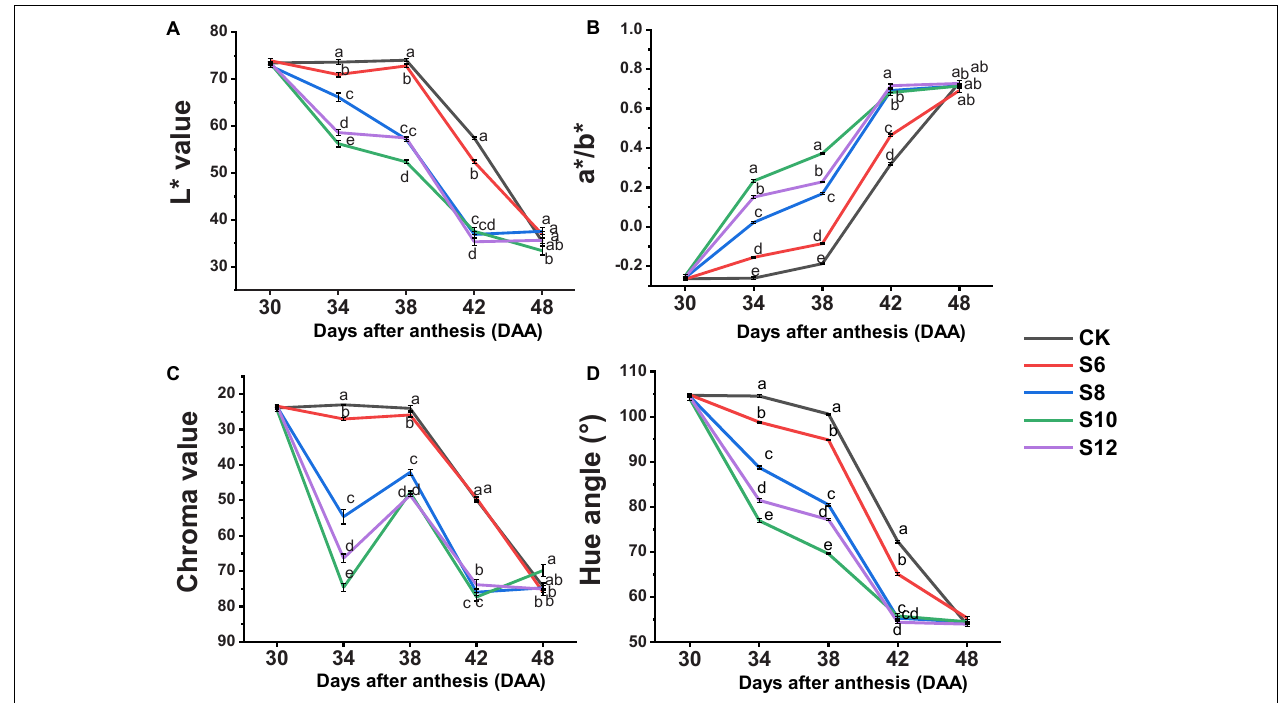
FIGURE 3 | Effect of different supplemental blue light frequencies on surface color values [L*, a*/b*, chroma, and hue angle; (A–D) ] of tomato fruit during different growth stages. Values are means ± SD ( n = 3). Different letters denote significant differences among treatments at each sampling day after anthesis separately ( p ≤